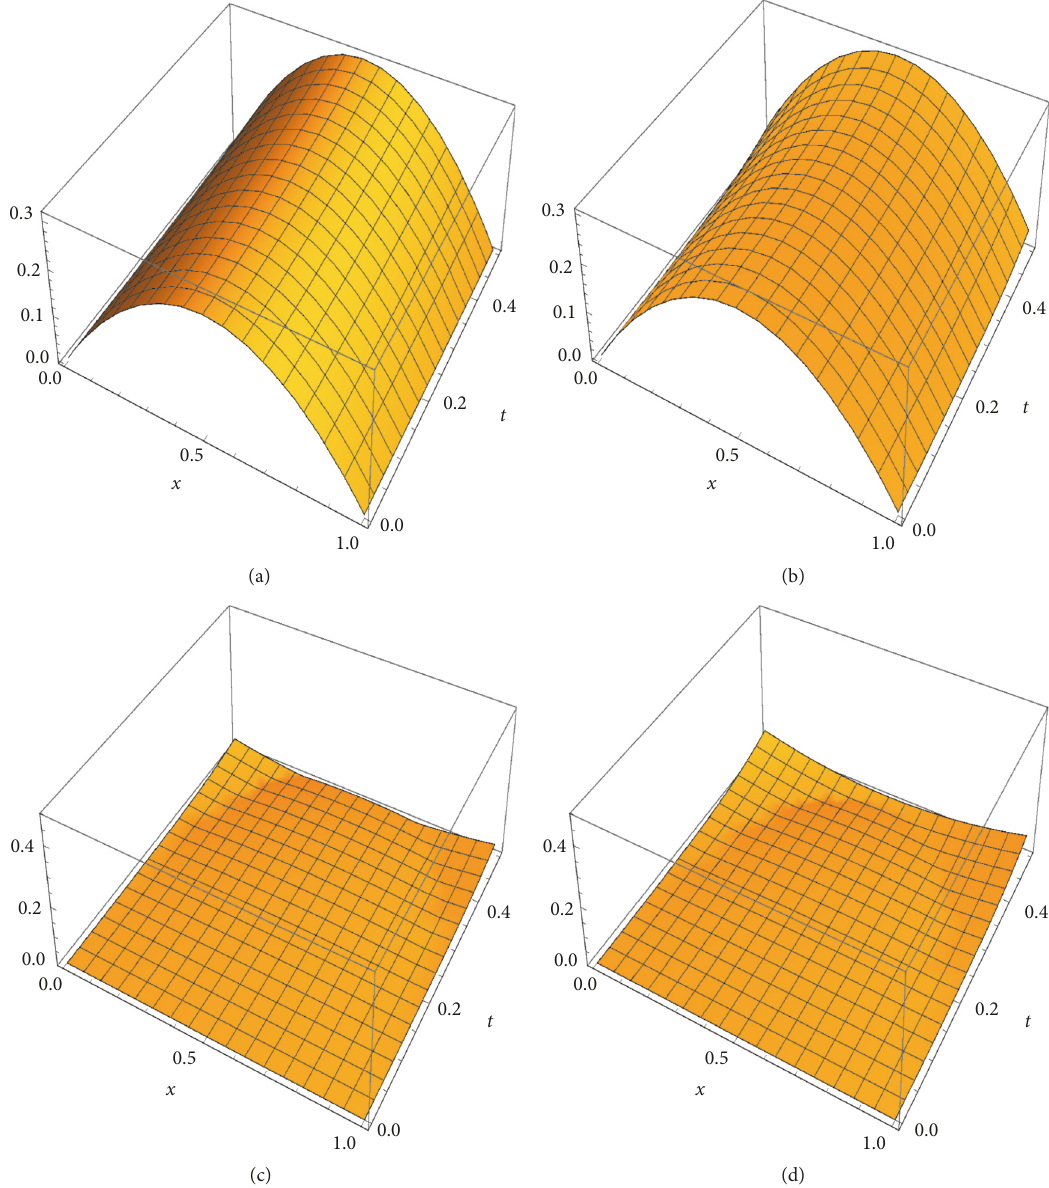
Figure 4: (a) Nonfractional (exact), (b) approximate solution 𝛼 1 = 𝛼 2 = 1 (3-term FRDTM), (c) absolute error between nonfraction exact solution and nonfractional approximate solution when 𝛼 1 = 𝛼 2 = 1 , and (d) absolute error between nonfraction exact solution and fractional approximate solution when 𝛼 1 = 𝛼 2 = 0.9